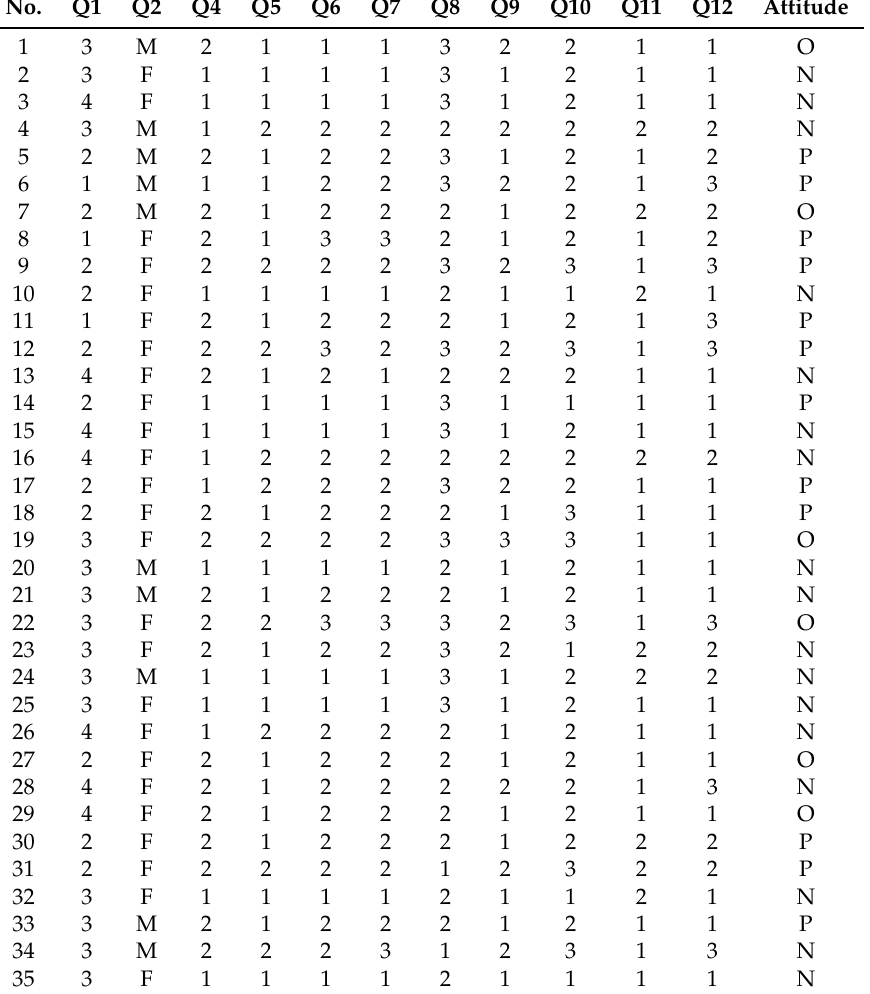
Table A1. Questionnaires about English learning attitudes for